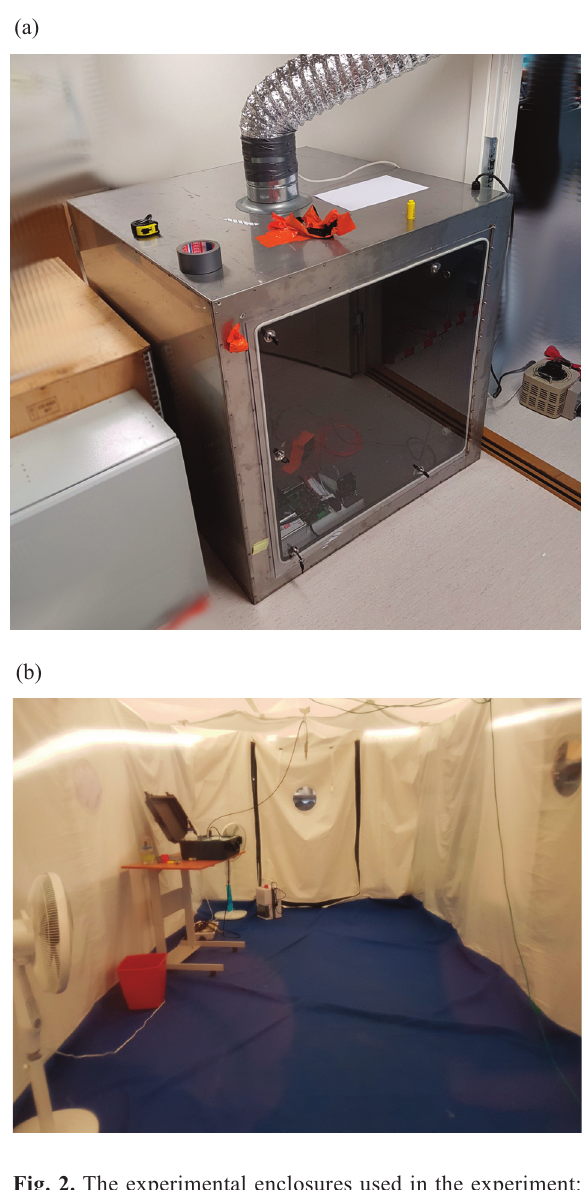
Fig. 2. The experimental enclosures used in the experiment: (a) one­cubic­meter stainless steel enclosure for online device testing; (b) the internal view of the larger 36 m 3 tent used on Cleamix Oy premises for long­exposure decontamination